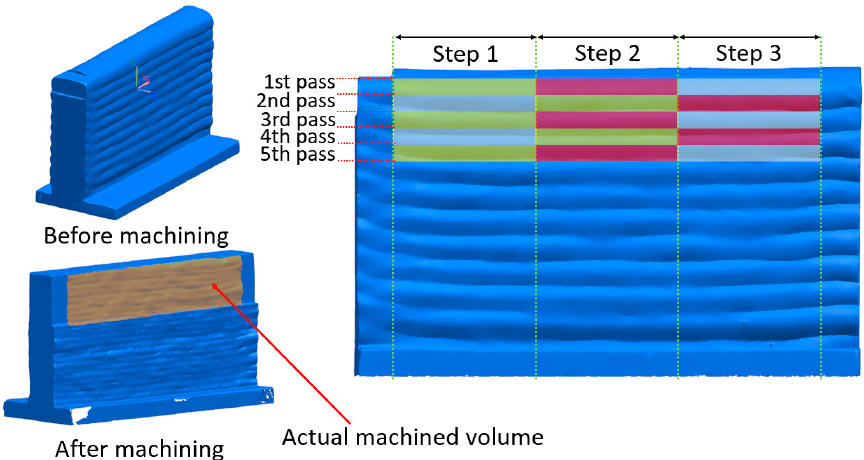
Figure 6. Division of a 3D scanned workpiece into equal regions for the calculation of the actual machined volume.